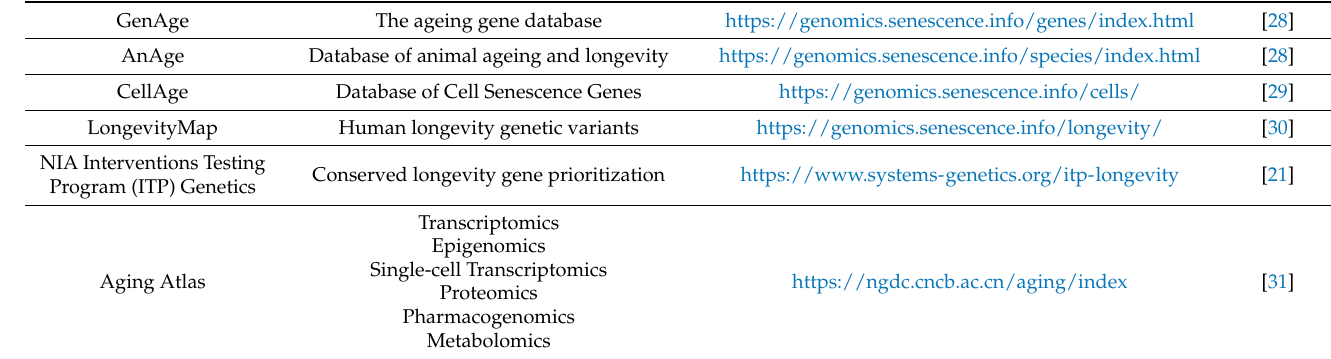
Table 1. Aging-related genetics and epigenetics databases, accessed on 20 December